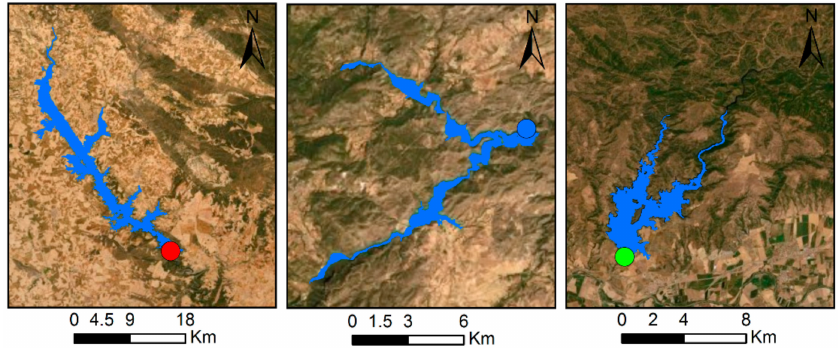
Figure 8. Three examples of reservoir extent and their dams (circle) studied in the Iberian Peninsula. From left to right: Alarcon (red), Fuensanta (blue) and La Brena (green) reservoirs. Areas (in blue) correspond to the maximum water extent derived from the Global Surface Water dataset. World imagery obtained from http: // goto.arcgisonline.com / maps / World_Imagery. Table 3. Alarcon, Fuensanta and La Brena reservoir characteristics (source: MAPAMA). Reservoir Alarcon Fuensanta La Brena Latitude 39.57 ◦ N 38.39 ◦ N 37.83 ◦ N Longitude 2.11 ◦ W 2.21 ◦ W 5.04 ◦ W River Jucar Segura Guadiato Catchment (km 2